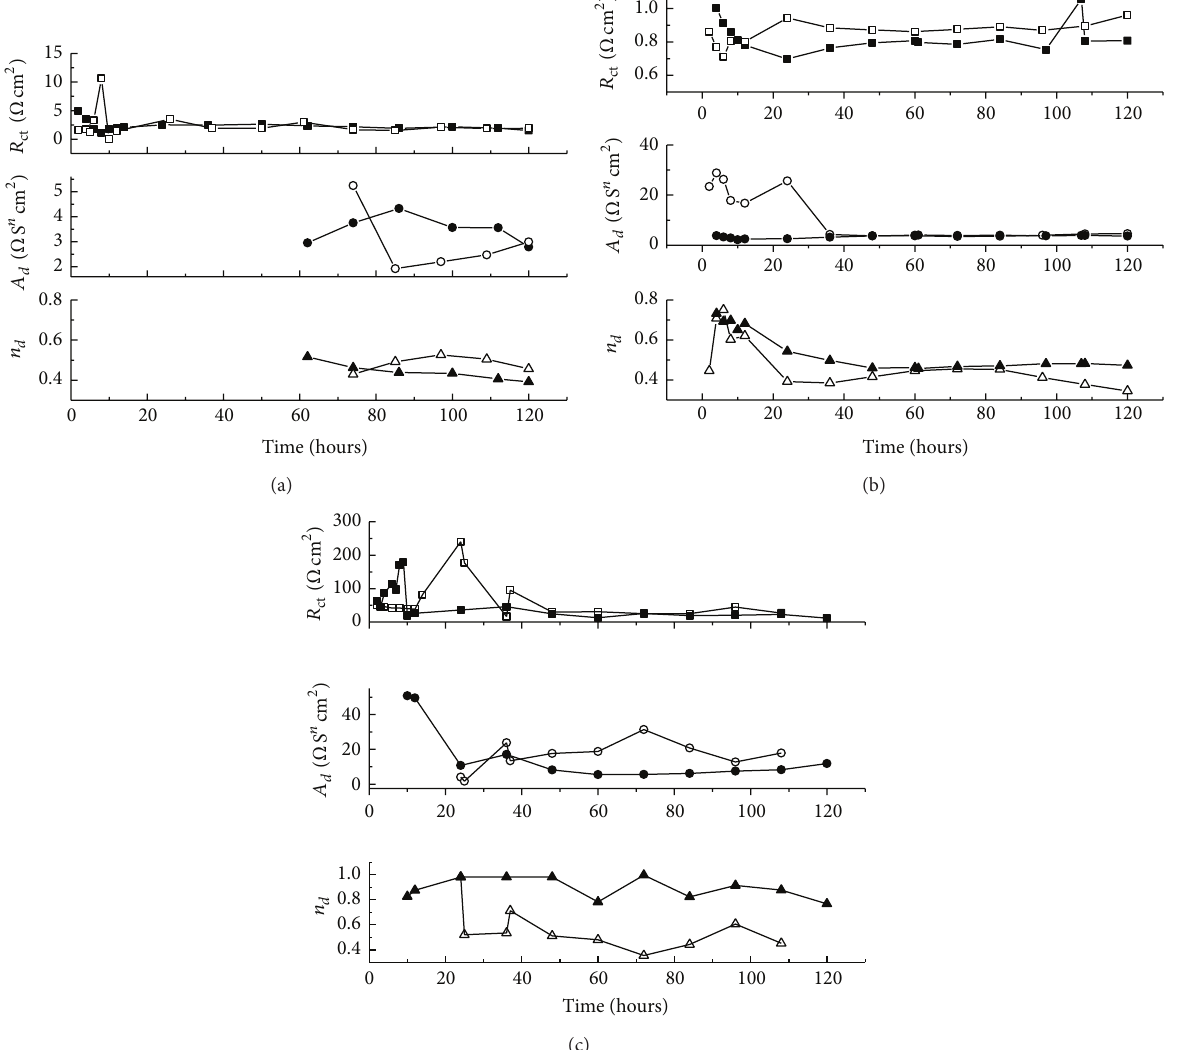
Figure 10: Comparison of the simulated parameters of the P92 (a), SS304 (b), and SS310 (c) between two repetitions in terms of 𝑅 𝑛 𝐴 𝑑 (circle), and 𝑑 (circle). The filled data corresponding to those listed in tables and the open mark are the replicate.